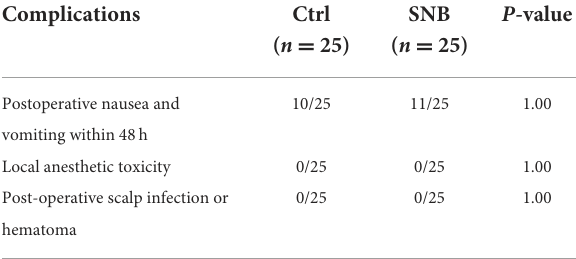
TABLE 3 The incidence of PONV, local anesthetic toxicity, and SNB